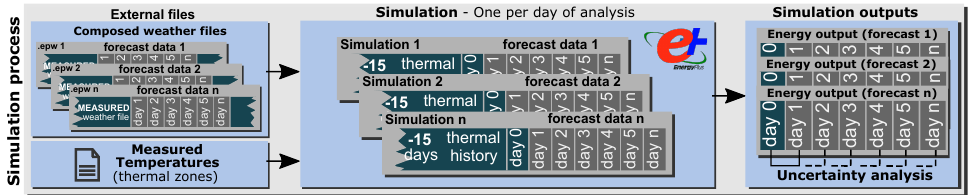
Figure 2. Simulation process methodology [53].